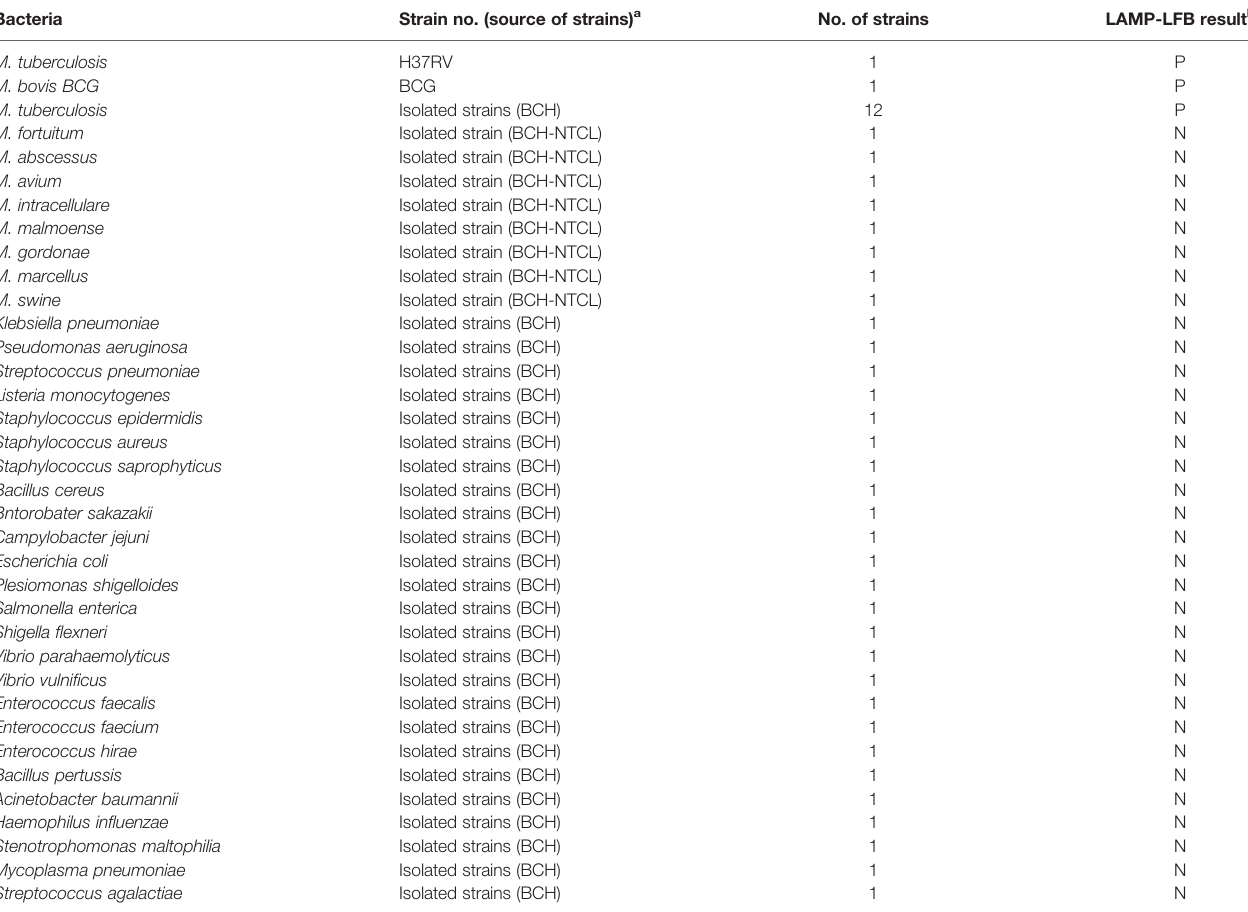
TABLE 2 | Bacteria strains used in this study.